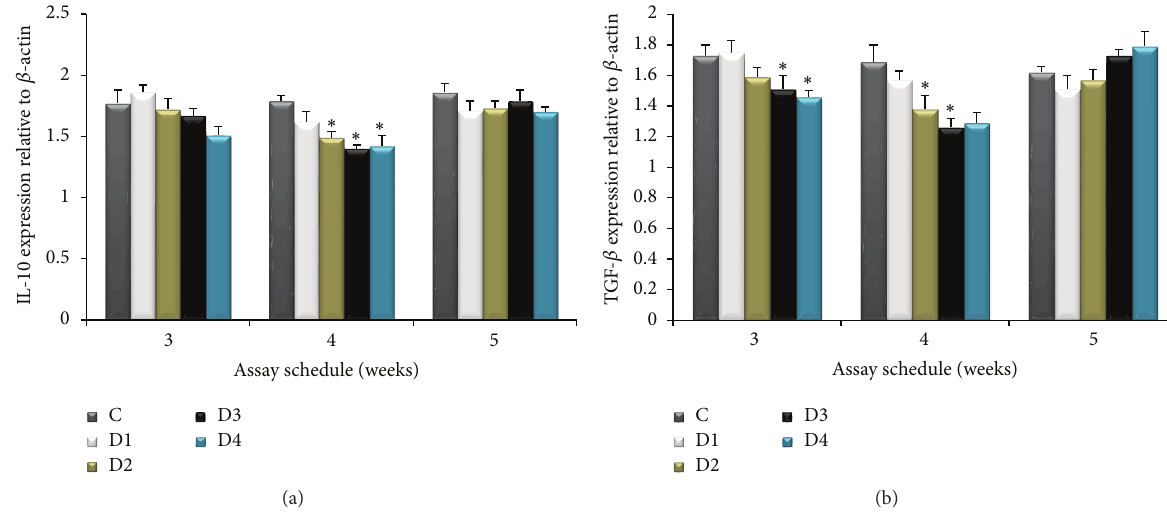
Figure 3: The relative mRNA expression of IL-10 and TGF- 𝛽 in the head kidney of Labeo rohita at the end of weeks 3, 4, and 5 after administration of varying concentrations CBP. Bars represent the mean ± SEM ( 𝑛 = 15 ) and asterisks represent levels of significant differences compared to the control ( 𝑃 < 0.05 ). Note: C (basal diet); D1 (basal diet + 0.1% CBP); D2 (basal diet + 0.2% CBP); D3 (basal diet + 0.3% CBP); D4 (basal diet + 0.4% CBP). ∗∗ ∗∗ ∗